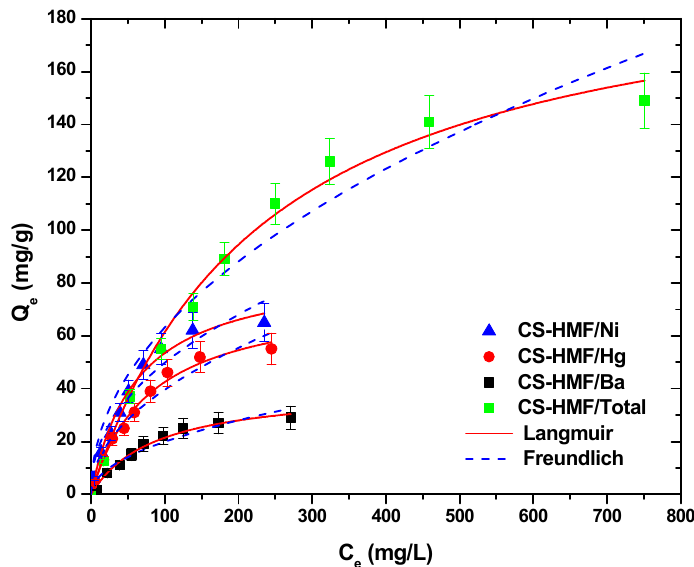
Figure 7. Equilibrium data for the uptake of Ni 2+ , Hg 2+ , and Ba 2+ in multi-component aqueous solution, fitting to the equations of Langmuir and Freundlich. Testing conditions: T = 25 ◦ C, C 0 = 10.0–300.0 (mg/L), N = 160 rpm, V = 20.0 mL, t = 200 min, m = 0.02 g, pH = 6.